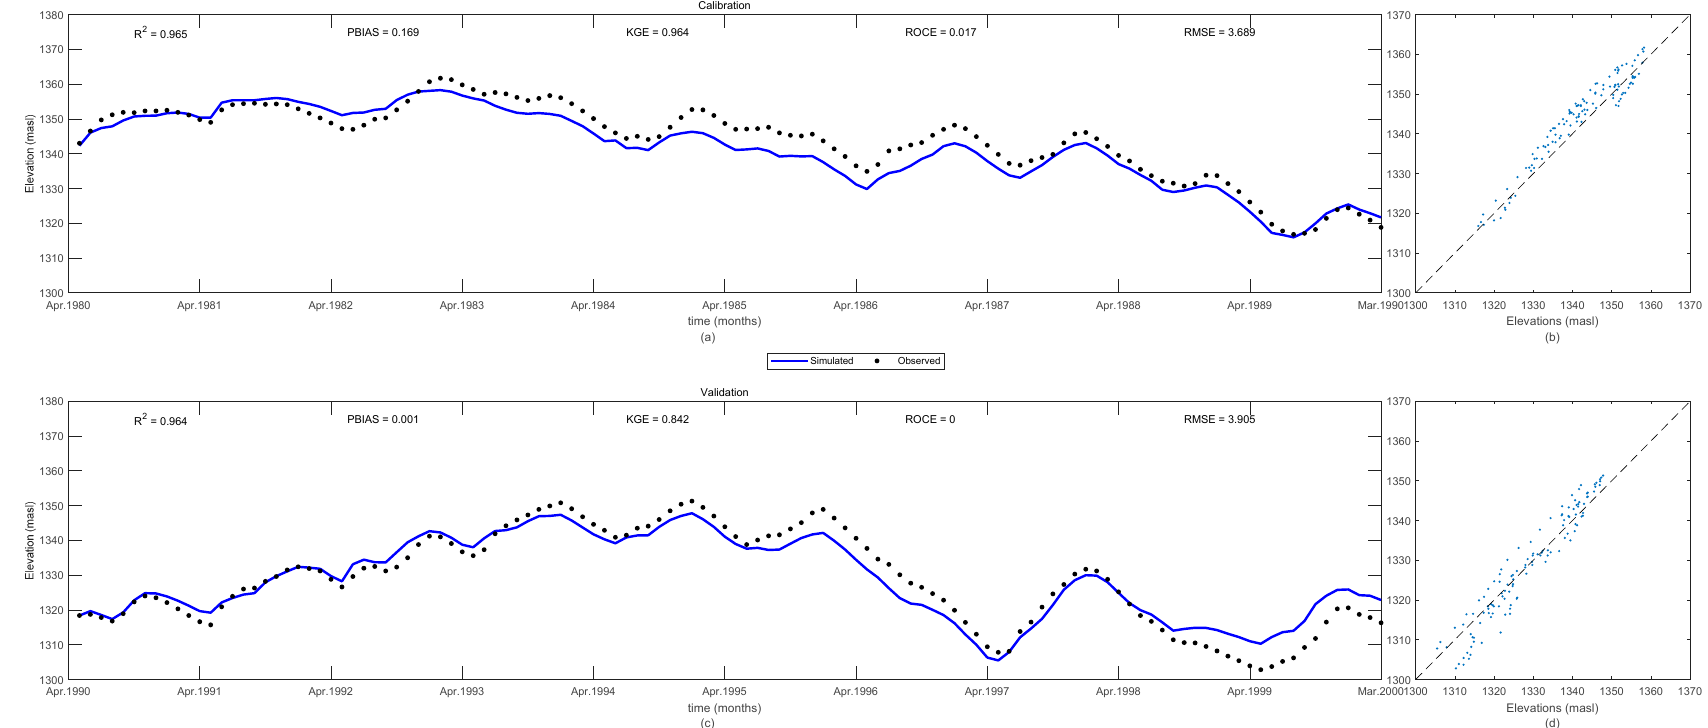
Figure 5. Left panel. Observed (dotted lines) and simulated (blue lines) lake levels (elevations) from April 1990 to March 2000 for the calibration period ( a ) and the validation period ( c ). Performance metrics correlation coefficient (R 2 ), Percentage of BIAS (PBIAS), Kling-Gupta Efficiency (KGE), Run-Off Coefficient Error (ROCE), and Root Mean Squared Error (RMSE) are shown in each graph. Right panel. Scatter plots of simulated and observed lake elevations for calibration ( b ) and validation ( d ).